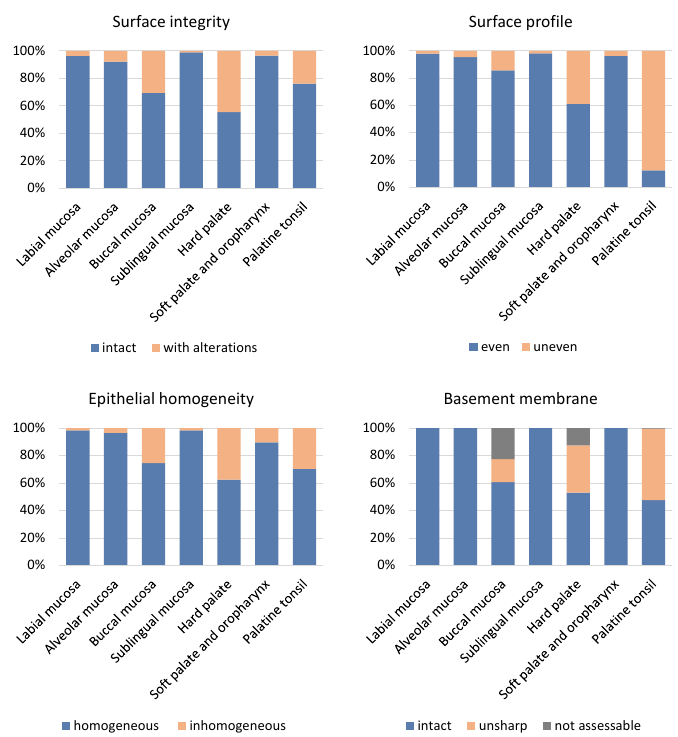
Figure 4. Results of the evaluation of the OCT cross sections within seven oral investigation areas. The image analysis contained the assessment of surface integrity, surface profile, epithelial homogeneity and basement membrane. Percentage values of the qualitative evaluation of the different criteria are presented by the colored bars.